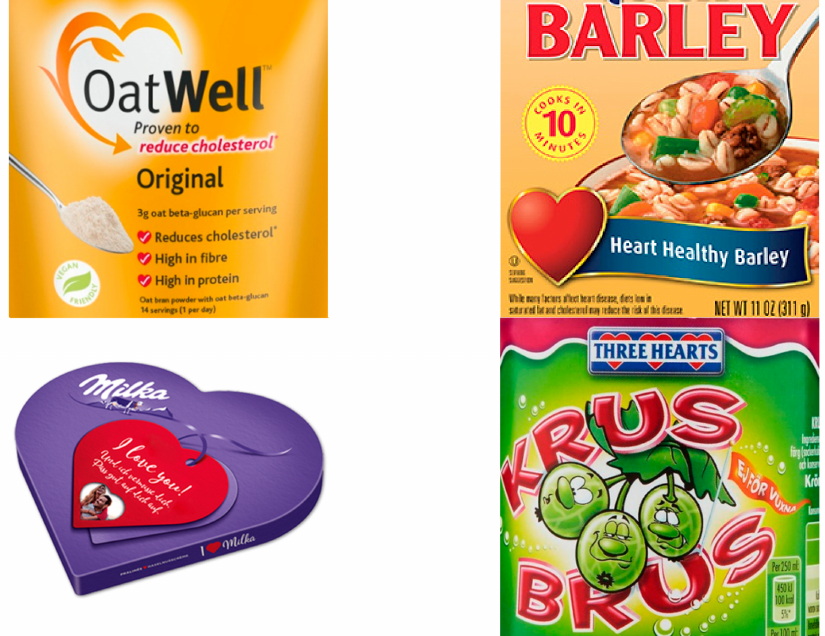
Figure 1. Examples of food labels with heart images in the international food supply (see Acknowl- edgements section for